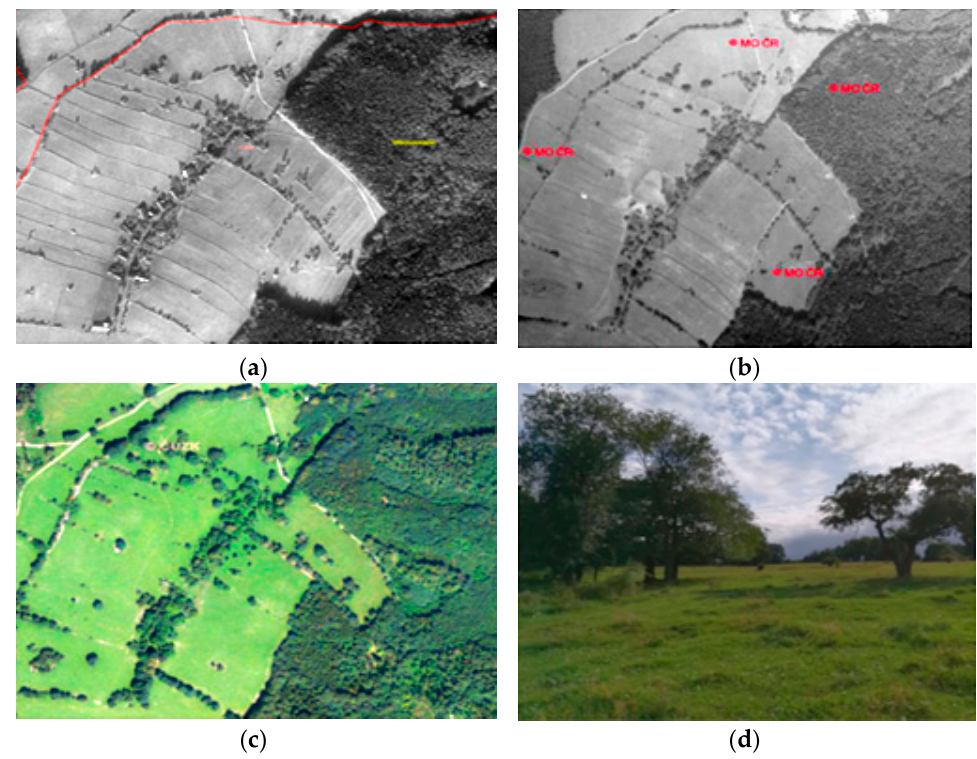
Figure 4. Case study of H ř ibová (Pilzberg in German, a settlement of Vl č ice municipality): aerial survey images from ( a ) 1937, ( b ) 1964 and ( c ) 2019 Source: https://ags.cuzk.cz/archiv/ accessed on 21 March 2004, ( d ) photograph of the current landscape (the authors).